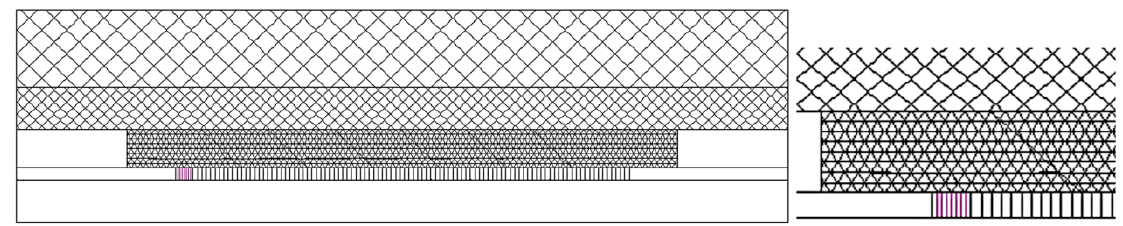
Figure 6. The state of the model during the stage representing the execution of the longwall cross-cut.